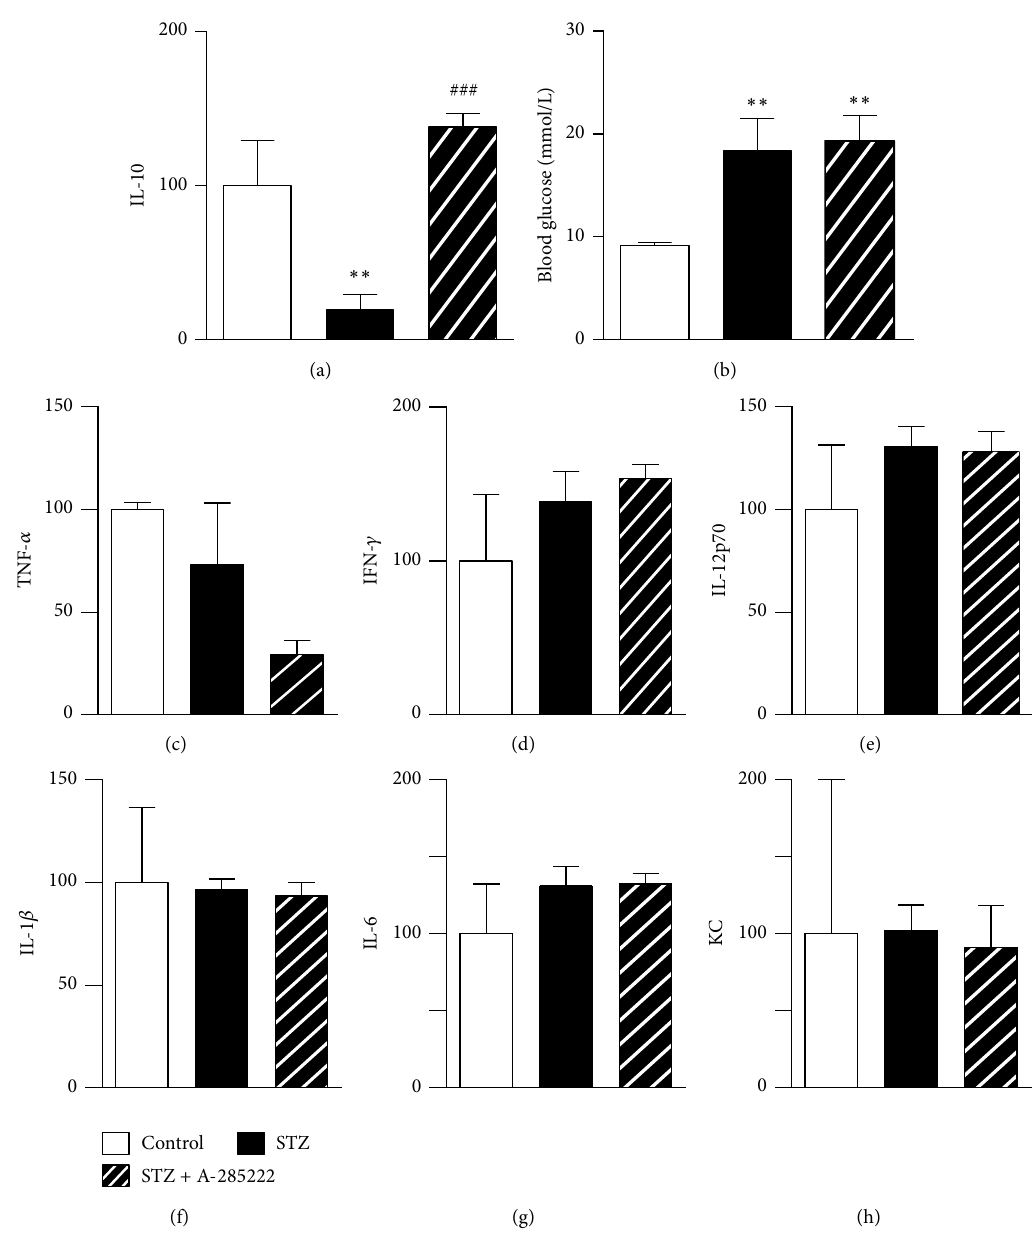
Figure5: Invivo inhibitionofNFATrestoreslevelsofanti-inflammatoryIL-10intheretinaofdiabeticmice.(a)LevelsofIL-10inwhole-retina homogenates from NFAT-luc mice, treated with STZ (60 mg/kg) or vehicle (citrate buffer). Mice received daily i.p. injections of A-285222 (0.15mg/kg) or vehicle (saline) for two weeks ( 𝑁 = 2 , 7, and 9 for control, STZ, and STZ + A-285222, resp.). ∗∗ 𝑃 < 0.01 versus control and ### 𝑃 < 0.001 versus STZ. (b) Blood glucose levels in mice treated as in (a) ( ∗∗ 𝑃 < 0.01 versus control; 𝑁 = 7–12 mice/group). (c)–(h) TNF 𝛼 , IFN- 𝛾 , IL-12p70, IL-1 𝛽 , IL-6, and KC levels were determined in whole-retina homogenates from the same mice as in (a). Cytokines levels were normalized to protein content and are expressed as percentage of control. No significant differences were observed between the groups. family members. In the intact mouse retina, all four isoforms but here we show that endothelial NFATc3 seems to be could be detected, whereas in isolated retinal vessels only sensitive to changes in extracellular glucose as well. NFATc2 and NFATc3 were demonstrated. This suggests that NFATc1 and NFATc4 may be of neuronal origin [26, 27] or may be upregulated in culture, given that primary retinal endothelial cells expressed all four isoforms. Our previous work in conduit and resistance arteries focused on the effects of glucose on NFATc3 in vascular smooth muscle cells [2],